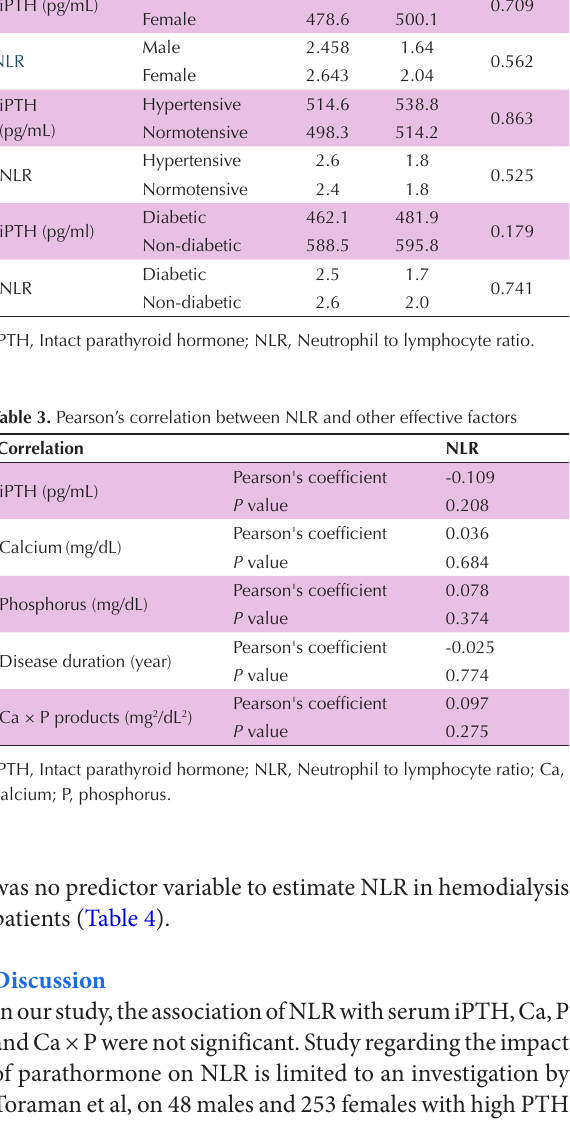
Table 4. Linear regression to predict the neutrophil-to-lymphocyte ratio Unstandardized Variable